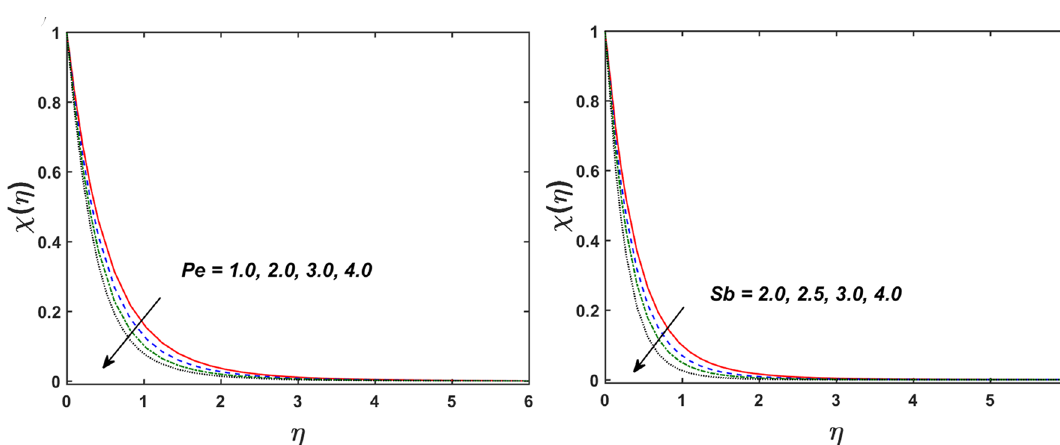
Figure 10. Variation in χ(η) for Pe and Sb